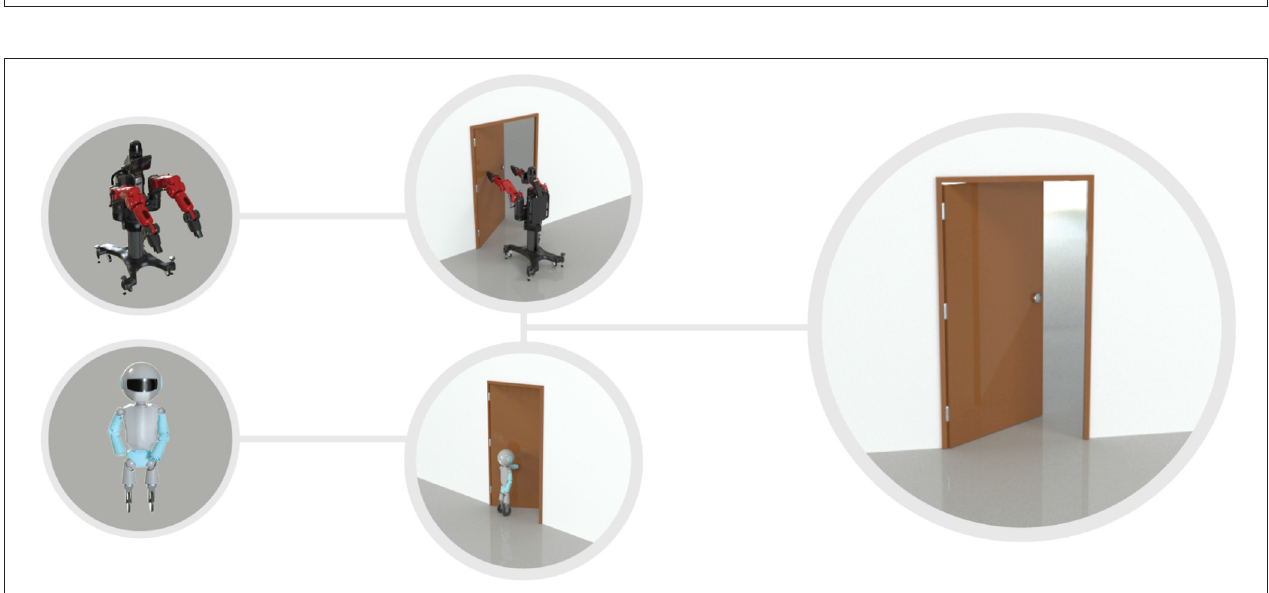
FIGURE 1 | Example of equivalence between two objects for cleaning a whiteboard: a wiper and an eraser. The robot affords to clean the white board by wiping it either with a wiper or an eraser.